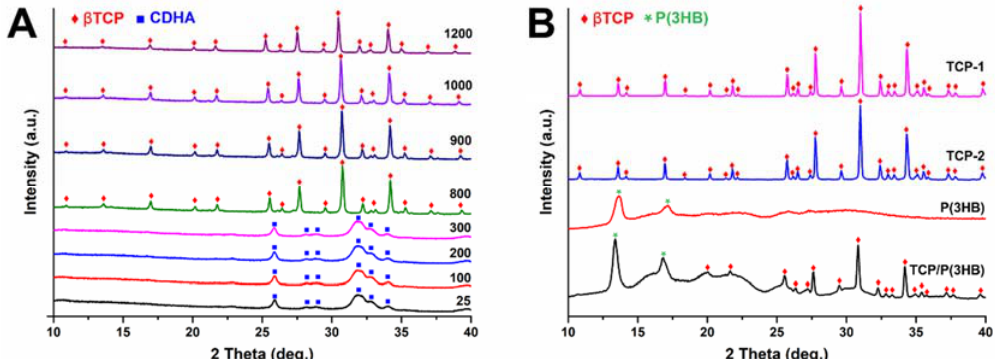
Figure 2. The High-Temperature X-ray Diffraction (HT-XRD) patterns of ( A ) Ag- β TCP powder measured in temperatures between 25 and 1200 °C and the XRD patterns of ( B ) TCP-1, TCP-2 scaffolds as well as polymer P(3HB) and coated composite TCP/P(3HB).